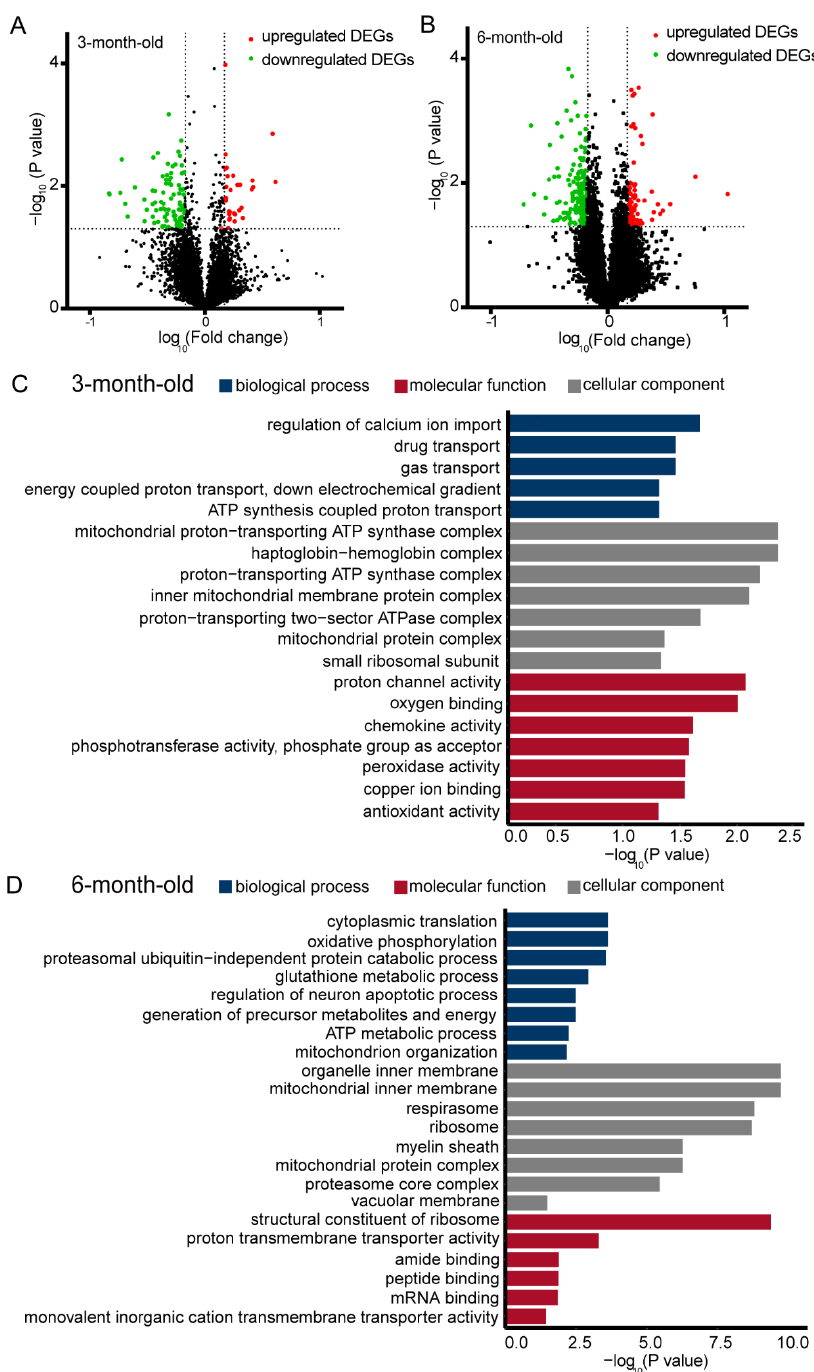
Figure 2. Differential gene expression in synaptodendrosomes of 3- and 6-month-old Alzheimer’s disease and wild-type mice. ( A ) Volcano plot of differentially expressed genes (DEGs) in 3-month-old mice (Alzheimer’s disease [AD] vs. wild-type [WT]; p < 0.05, fold-change ≥ 1.2 or ≤ 0.83). ( B ) Volcano plot of DEGs in 6-month-old mice (AD vs. WT; p < 0.05, fold-change ≥ 1.2 or ≤ 0.83). ( C ) The filtered DEGs from ( A ) were subjected to Gene Ontology (GO) enrichment analysis, and all 7 GO terms were selected ( p < 0.05, fold-change ≥ 1.2 or ≤ 0.83). ( D ) The filtered DEGs from ( C ) were subjected to GO enrichment analysis, and the top 8 most-enriched functional GO terms of the DEGs were selected with “biological process (BP)”, “cellular component (CC)”, and “molecular function (MF)” (p ≤ 0.05, fold-change ≥ 1.2 or ≤ 0.83). All analyses were performed in a pooled sample from an average of n ≥ 3